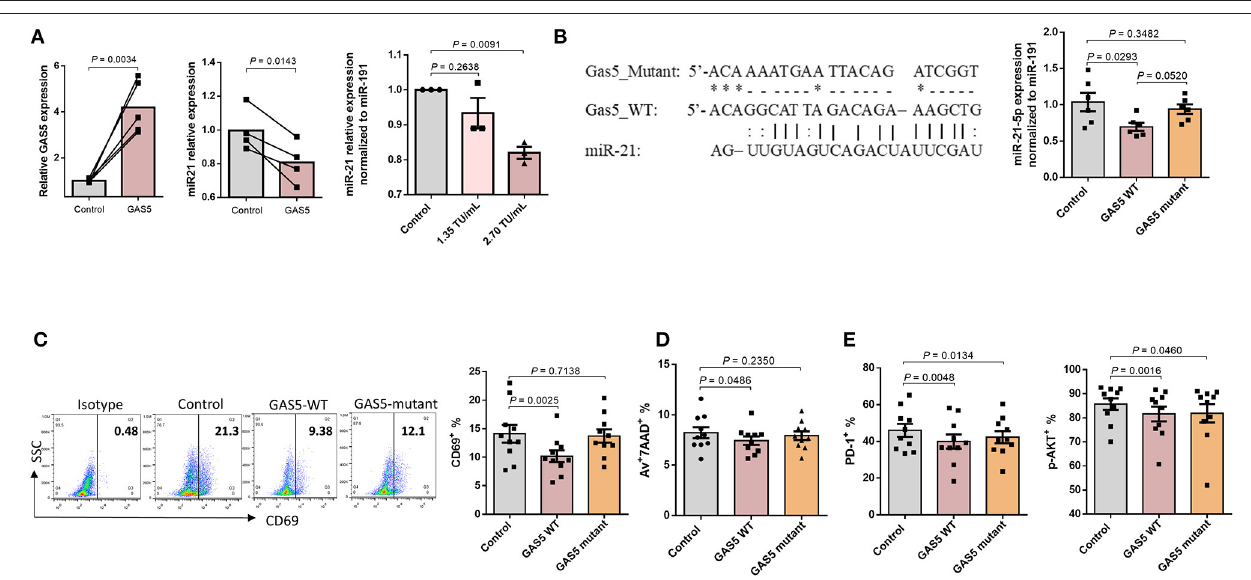
FIGURE 4 | MiR-21 controls CD4T cell response and apoptosis via regulating the TCR signaling pathways in PLHIV. T cell activation, exhaustion, cytokine production, apoptosis, and DNA damage marker expressions after miR-21 knockdown in CD4T cells from PLHIV were determined by Flow Cytometry and Western Blot. (A) Relative expression of miR-21 and GAS5 following miR-21 knockdown in CD4T cells from PLHIV determined by RT-qPCR ( n = 5). (B) Frequencies of pMAPK ( n = 9), pAKT ( n = 9), PD-1 ( n = 11), and Tim-3 ( n = 8). (C) Representative dot plot and summary data of IL-2 ( n = 16), IFN- γ ( n = 16), TGF β 1 ( n = 8), and TCF1 ( n = 7) expressions. (D) Representative dot plot and summary data of Av + 7AAD + CD4T cells ( n = 13), expression of active caspase-3 ( n = 10). (E) Representative histogram and summary data of γ H2AX expression ( n = 12). (F) Representative western blots and summary data of cleaved PARP-1 ( n = 8), pS6 ( n = 6), and γ H2AX ( n = 6) expressions, normalized to GAPDH.